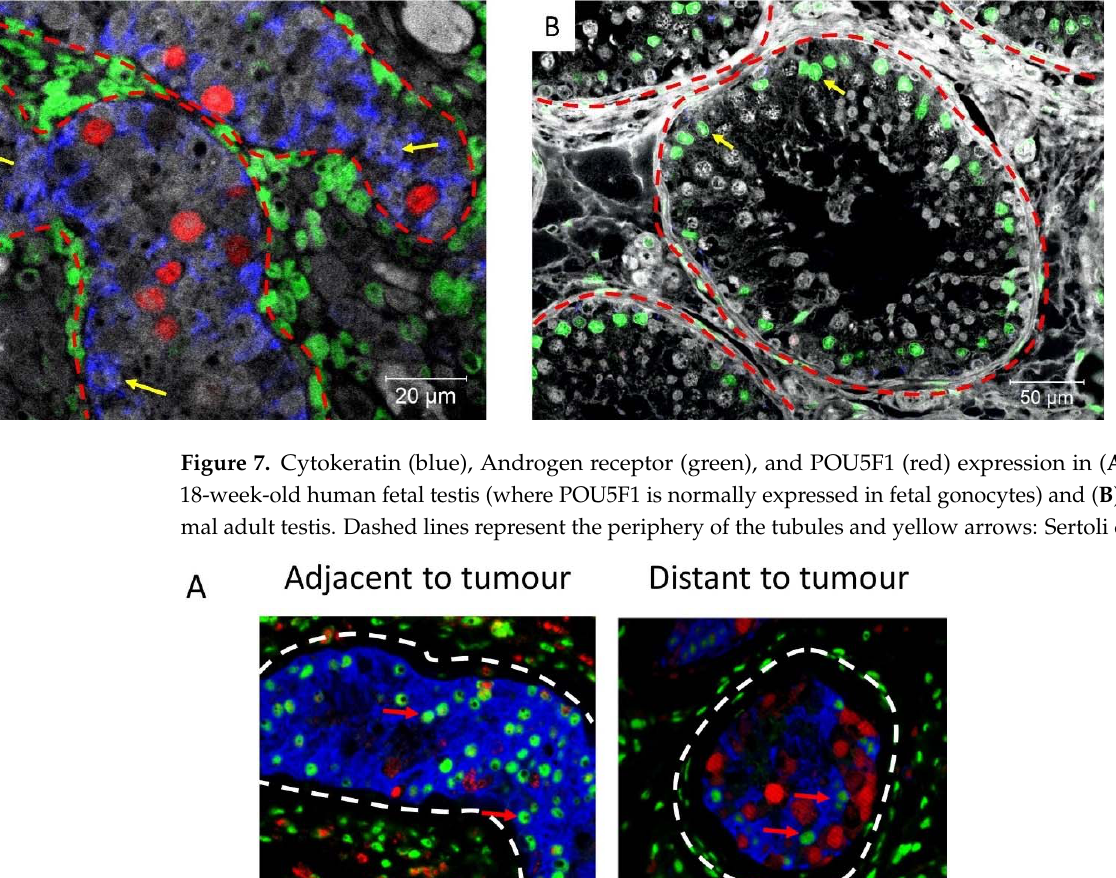
Figure 8. ( A ) Cytokeratin (blue), POU5F1 (GCNIS; red), and androgen receptor (AR, green) expression in Sertoli cells from GCNIS ‐ containing tubules located distant from the tumour and adjacent to the tumour. Dashed lines represent the periphery of the seminiferous tubules. Scale bars